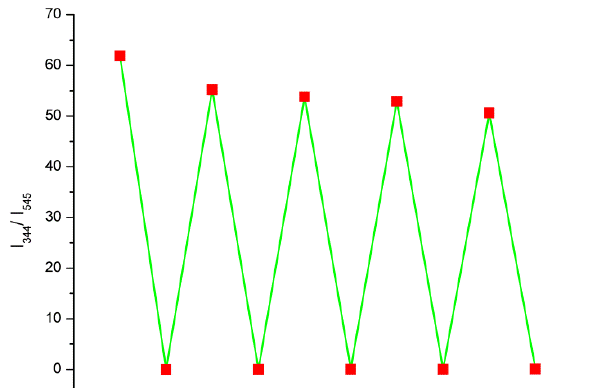
Figure 10. Cyclic response of luminescence intensities (I 344 /I 545 ) of the Tb(3+)@Sr-MOF for detecting sesamol.